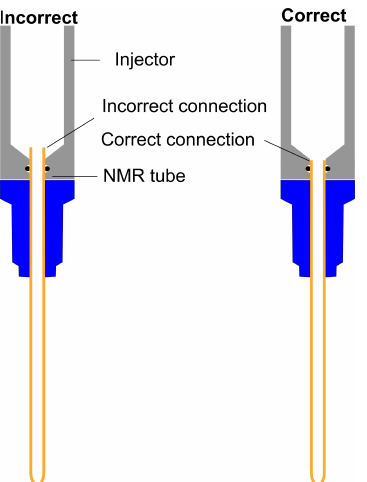
Figure E1. Schematic presentation of correct and incorrect connec- tions between the top part of the NMR tube and